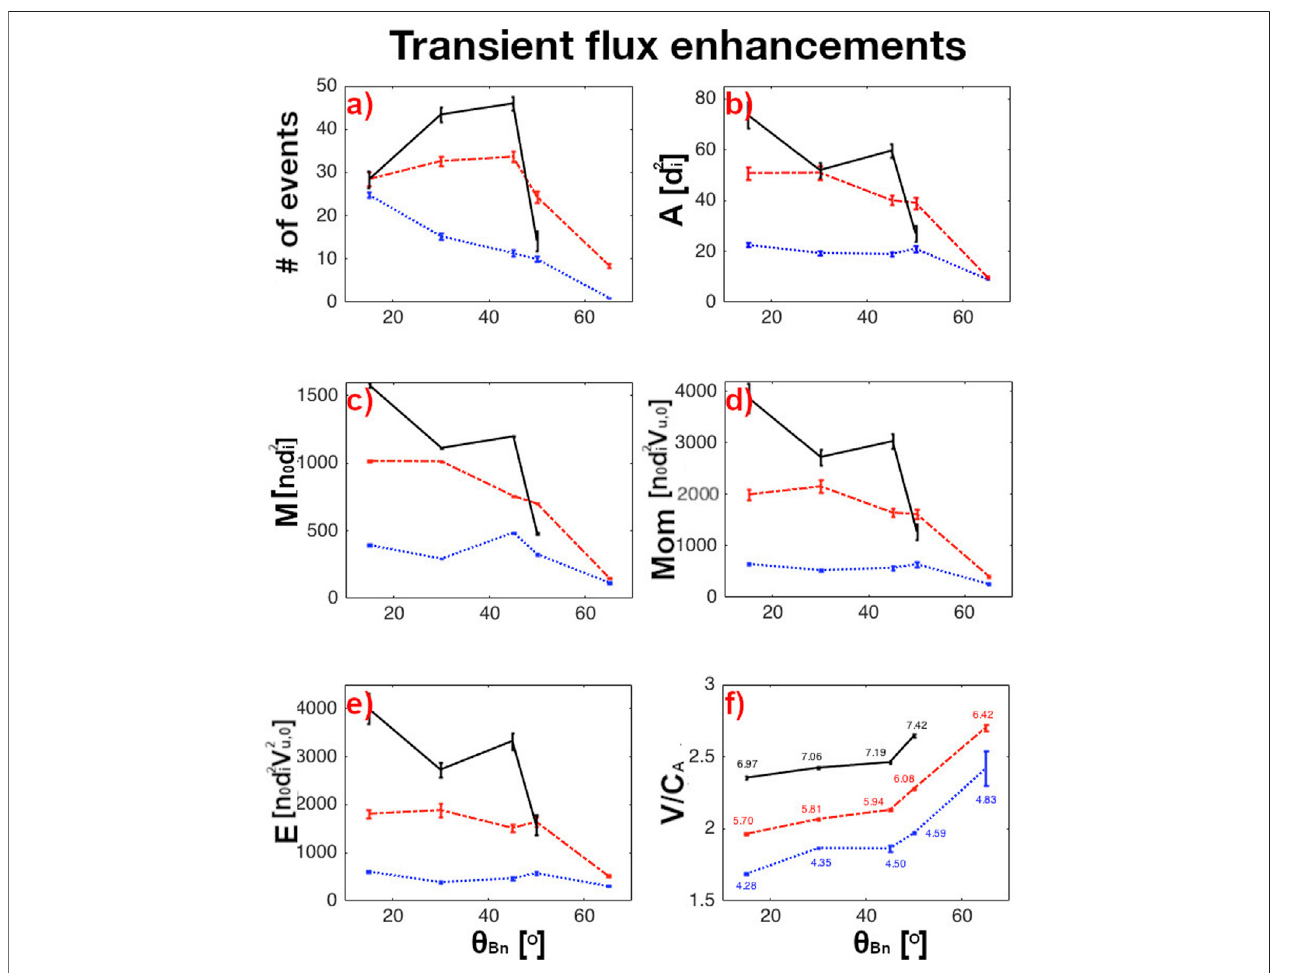
FIGURE4| Averagepropertiesoftransient fl uxenhancementsasafunctionof θ BN .Figure formatisthesameasin Figure3 .Theblue, theredandtheblacktraces represent properties of jets produced in runs with V in = 3.3 C A , 4.5 C A and 5.5 C A respectively. The units are given in brackets. The subindex u refers to the upstream region, while the subindex 0 means the initial